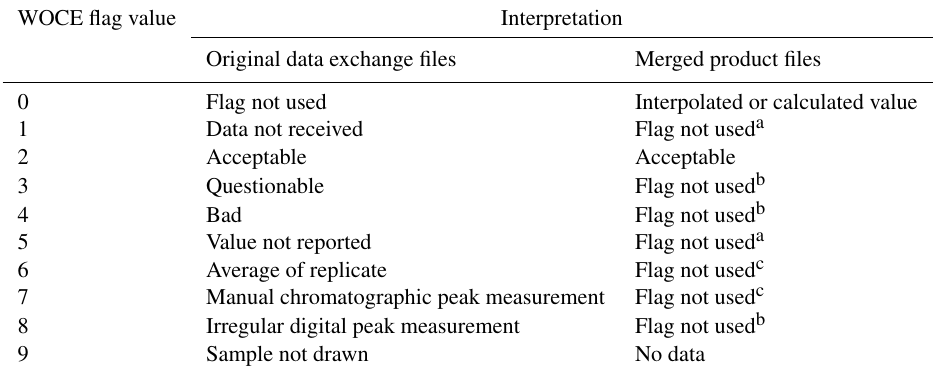
Table 2. WOCE flags in GLODAPv2.2020 exchange format original data files (briefly; for full details see Swift, 2010) and the simplified scheme used in the merged product files.